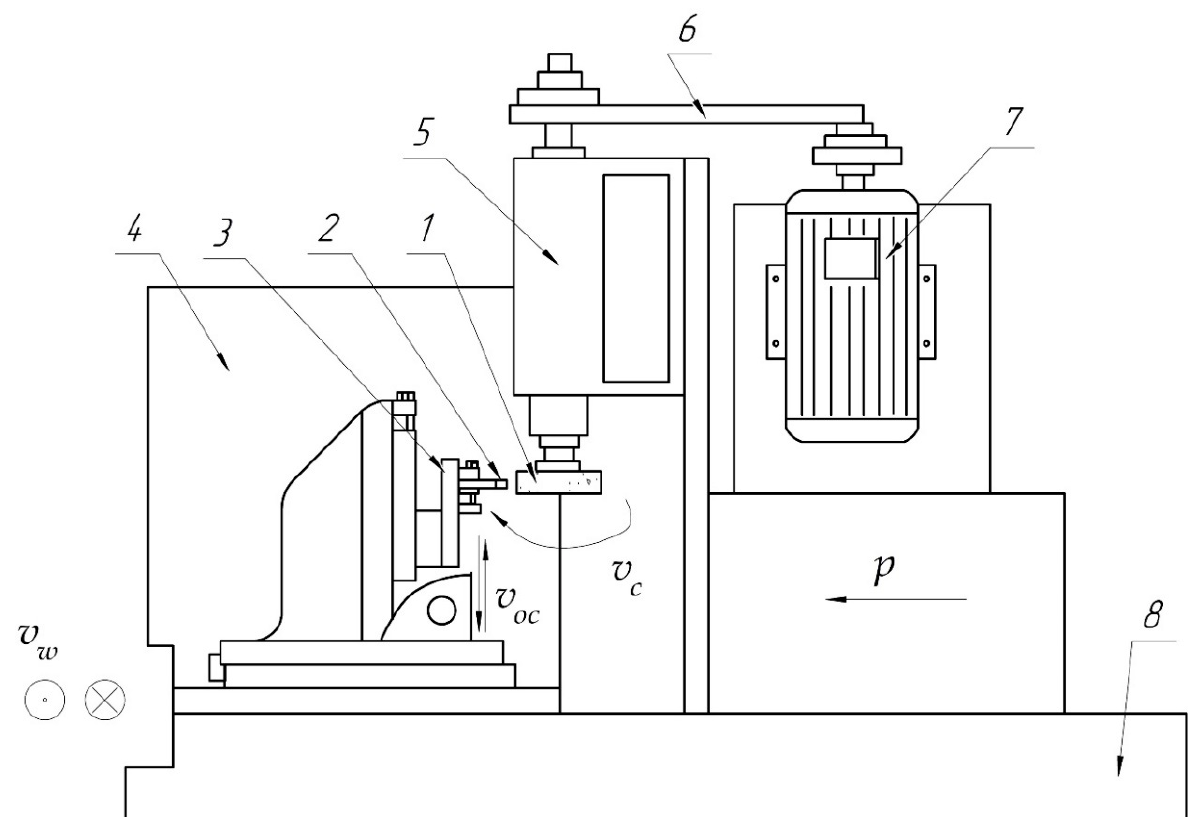
Figure 1. Belt grinding scheme: 1—grinding belt; 2—workpiece; 3—workpiece clamping device; 4—casing; 5—spindle unit (headstock); 6—belt drive; 7—electric motor; 8—machine stand; P —pressure; v c —belt speed; v w —workpiece speed; w os —vertical oscillation frequency.